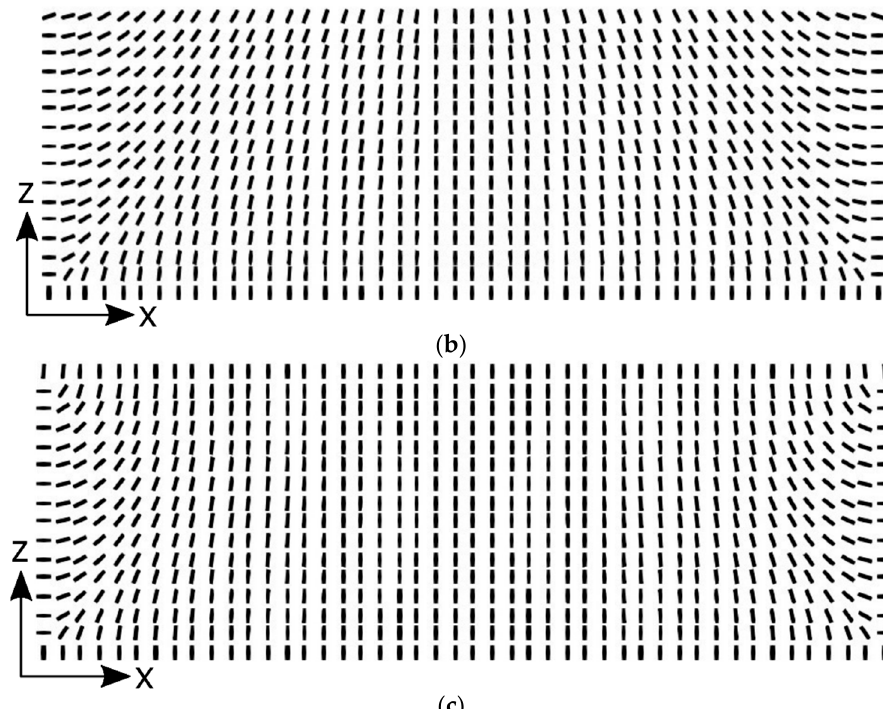
Figure 5. The steady-state bulk configuration is caused by variations in homeotropic anchoring energy at λ * = 10 3 for the nondimensional anchoring energy of 10, 40, 200 nondimensionalized surface viscosities. It shows how director configuration changes with respect to the film top interface alignment that depends on W . ( a ) The case study with the parameters of λ * = 103 and W = 10. ( b ) The case study with the parameters λ * = 103 and W = 40. ( c ) The case study with the parameters λ * = 103 and W = 200.